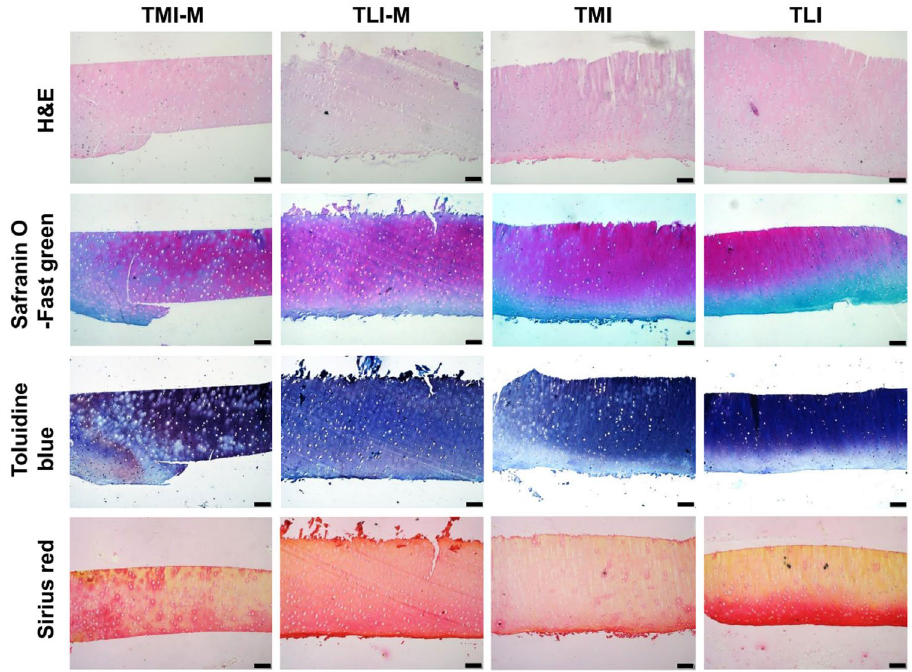
Figure 6. Histological analysis of specific regions in tibial cartilage using H&E, Safranin O-fast green, Toluidine blue and Sirius red staining. Scale bar: 100 μm.